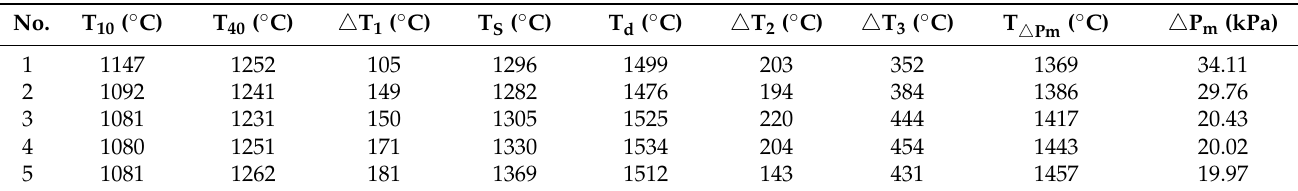
Table 4. The results of softening–melting